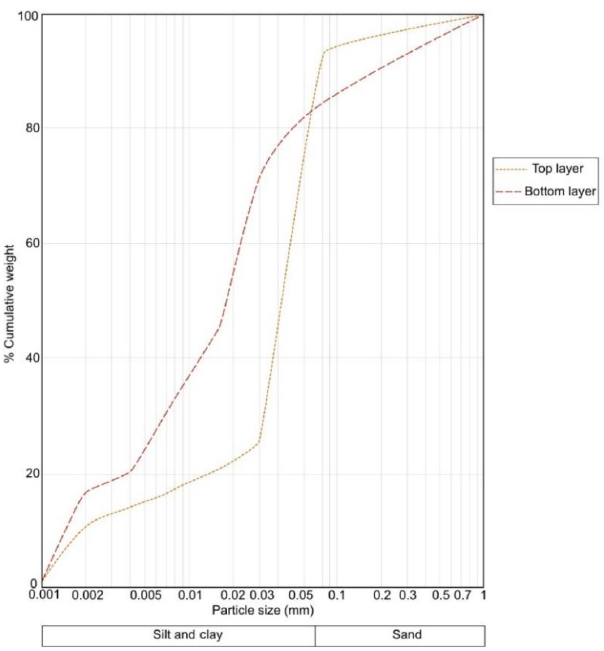
Figure 3. Accumulated particle size distribution in a composite sample from top and a composite sample from bottom layers of all core sediments (semi-log